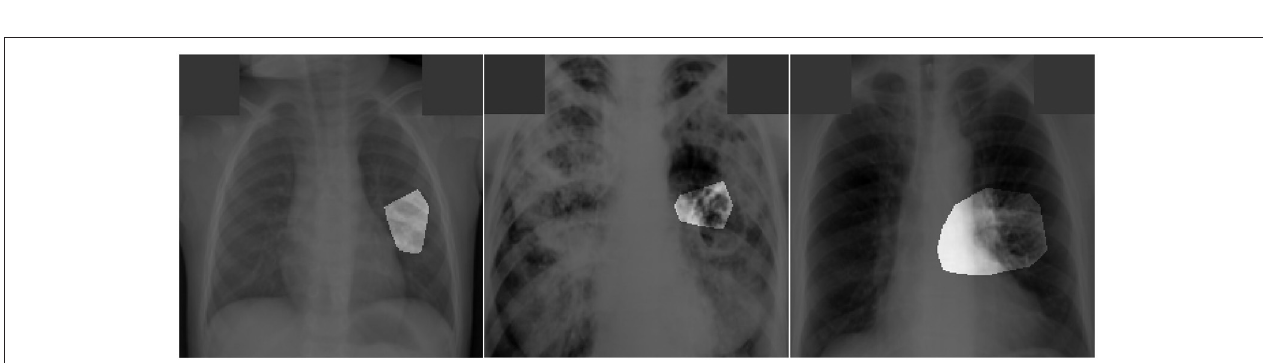
FIGURE 4 | Architectural and computational complexity comparison between the CheXNet (Rajpurkar et al., 2017) architecture vs. the proposed TB-Net architecture. As shown, TB-Net achieves ∼ 1.9 × fewer parameters and ∼ 6.7 × lower MACs.